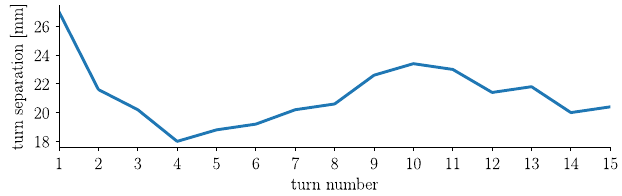
FIG. 6. Turn separation among subsequent orbits measured at the probe RRI2 (minimum 18.0 mm and maximum 27.0 mm).